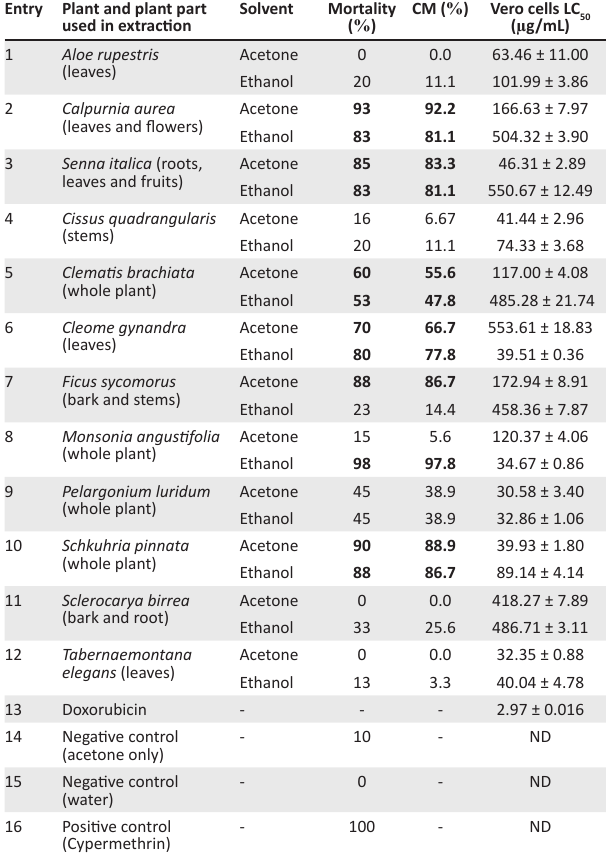
TABLE 1: The mortality, corrected mortality and concentration in mg/mL killing of 50 % of Vero cells (LC ) of the 12 indigenous South African plant species 50 screened against adult ticks of Rhipicephalus turanicus